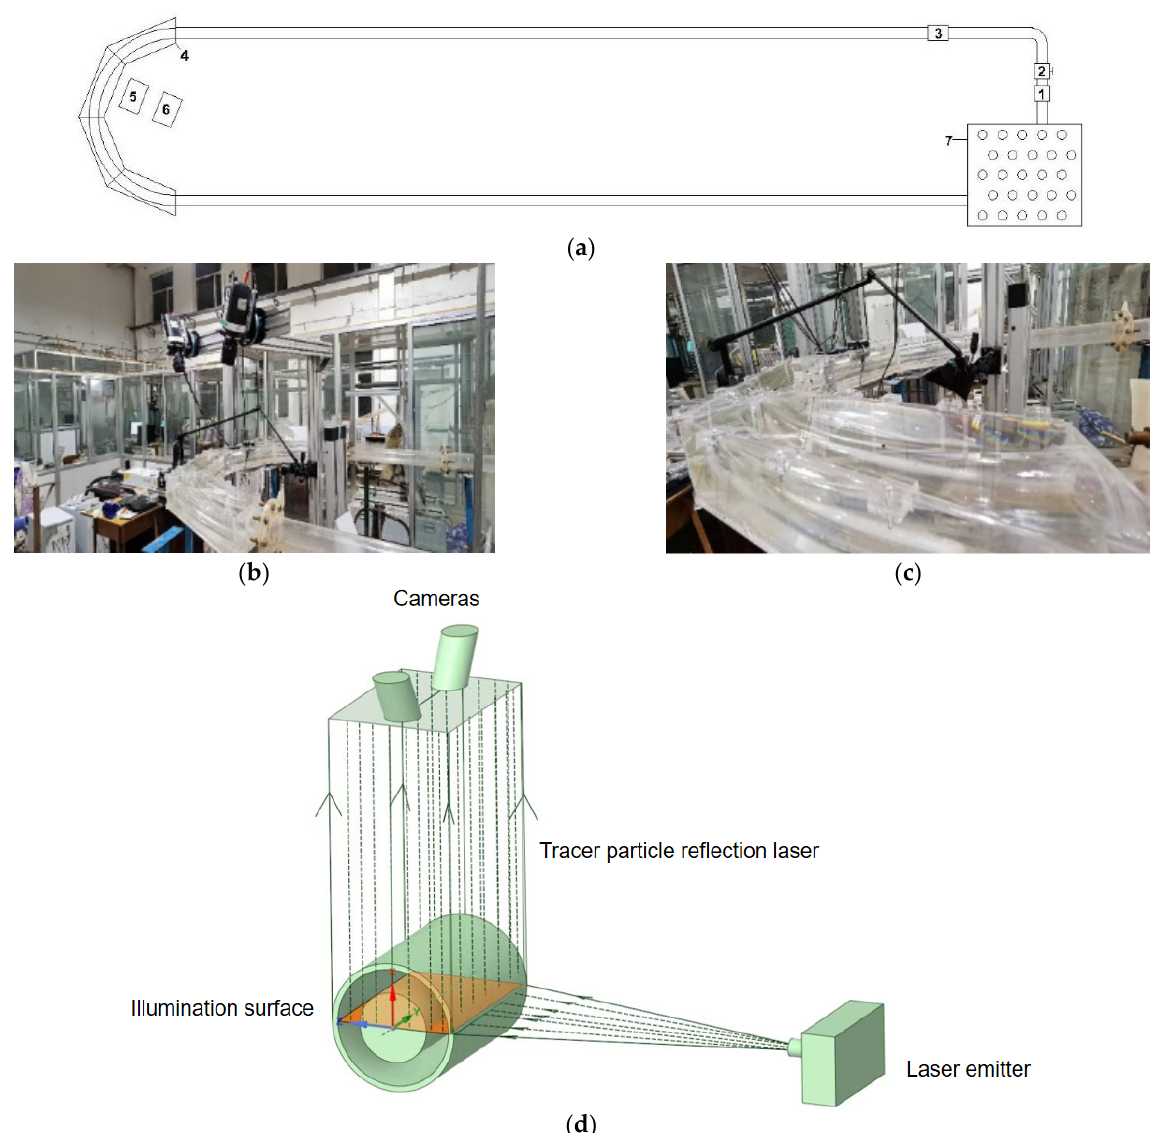
Figure 1. Layout of the test system: ( a ) schematic diagram, 1. centrifugal pumps, 2. gate valve, 3. electromagnetic flowmeter, 4. trapezoidal water jacket, 5. PIV, 6. workbench, 7. steel water tank; ( b ) PIV measuring; ( c ) bend pipe; ( d ) PIV schematic sketch.